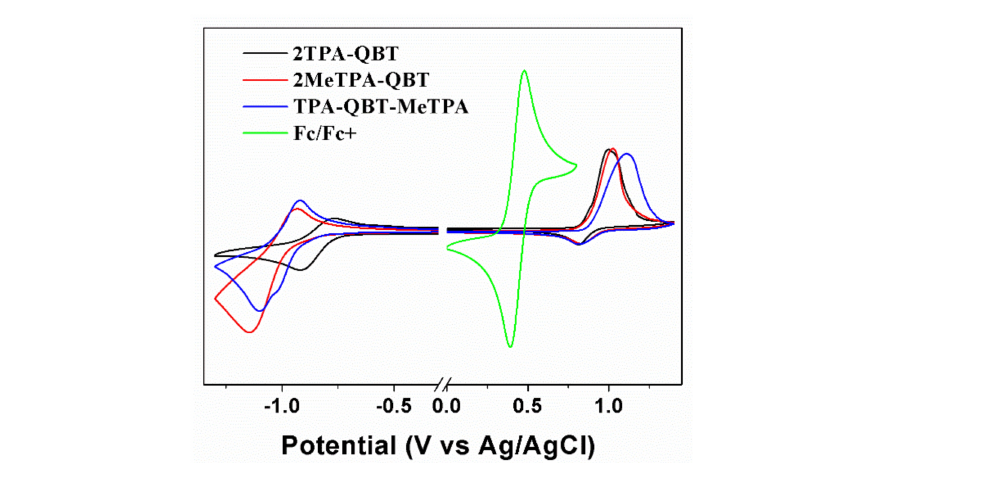
Figure 3. Cyclic voltammograms for emitter films on a platinum electrode in an acetonitrile solution